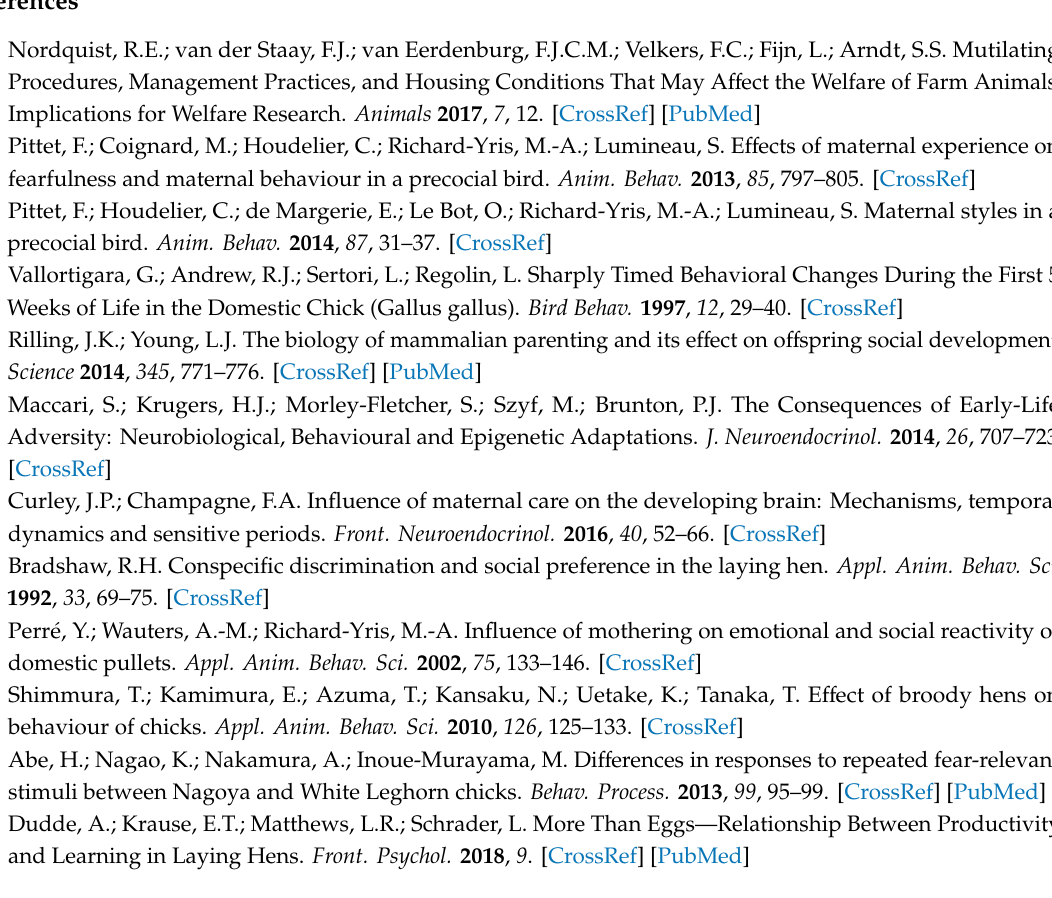
Table S1: Statistical results for open field test (Friedman ANOVA on ranked data), Table S2: Statistical results for voluntary human approach test (Friedman ANOVA on ranked data), Table S3A: Statistical results of between-subjects e ff ects for social versus foraging Y-maze test (Friedman repeated measures ANOVA on ranked data), Table S3B: Statistical results of within-subjects e ff ects for social versus foraging Y-maze test (Friedman repeated measures ANOVA on ranked data) Table S4A: Statistical results of between-subjects e ff ects for social recognition Y-maze test (Friedman repeated measures ANOVA on ranked data), Table S4B: Statistical results of Table S5A: Statistical results of between-subjects e ff ects for holeboard test (Friedman repeated measures ANOVA on ranked data), Table S5B: Statistical results of within-subjects e ff ects for holeboard test (Friedman repeated measures ANOVA on ranked